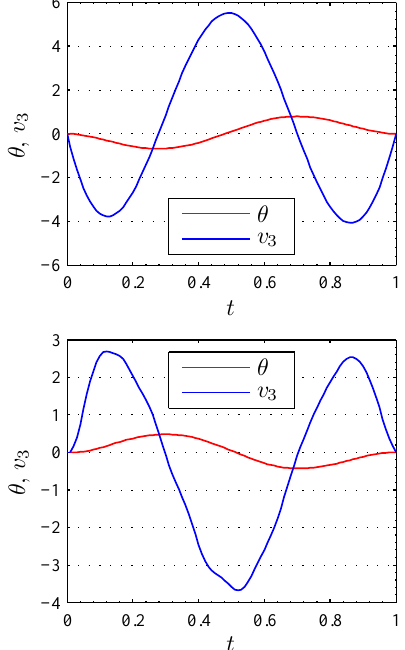
Figure 5. Orientation and angular velocity: egalitarian solution (top) and prioritarian solution (bottom).